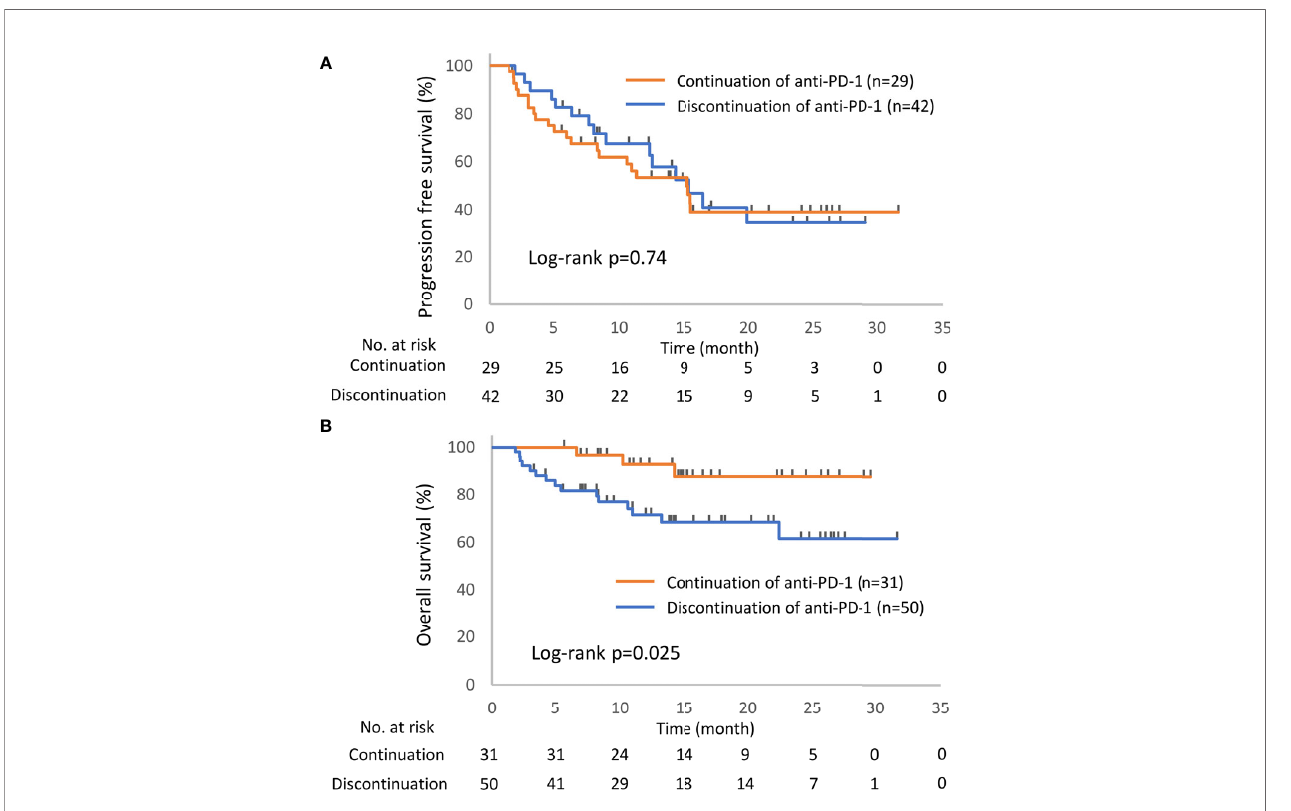
FIGURE 3 | Kaplan – Meier curves for the 6-week landmark analysis of the progression-free survival (A) and overall survival (B) of patients continuing or stopping PD- 1 treatment after irAE occurrence. PD-1, programmed cell death-1; irAE, immune-related adverse event.